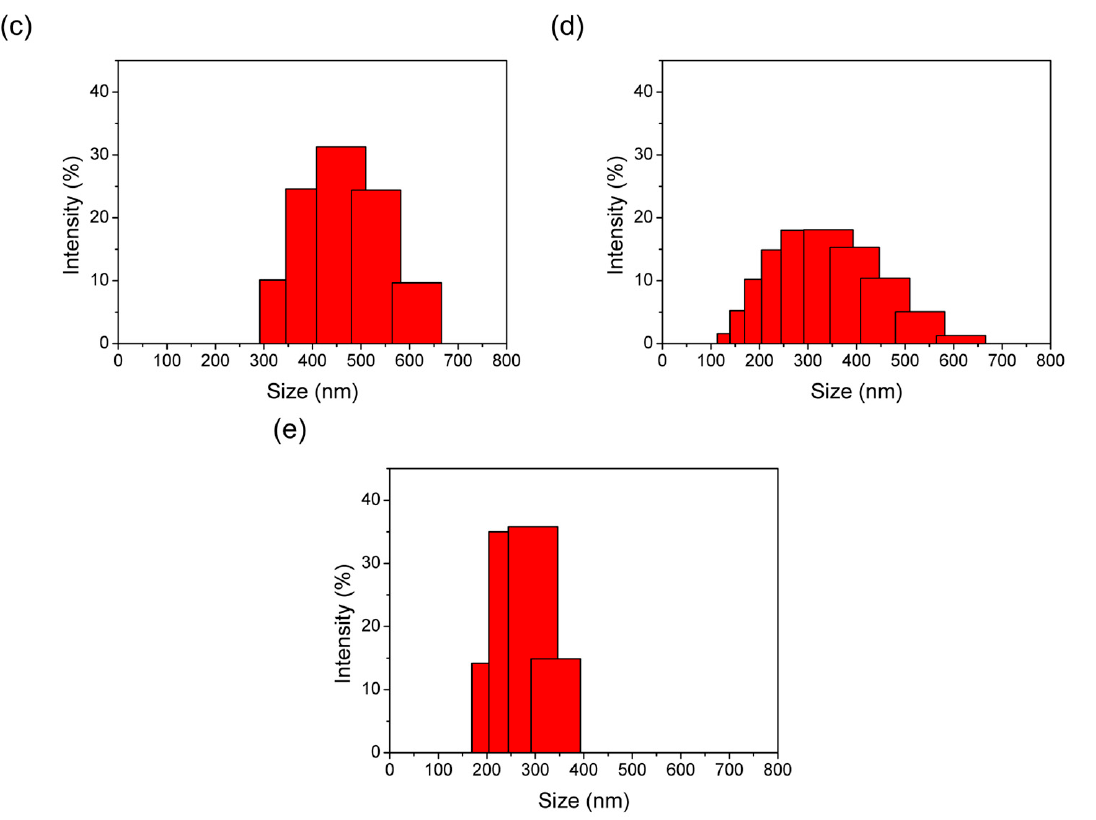
Figure 9. The DLS analysis of ZIF-8 samples with de novo- synthesis and impregnation methods using Ag 2 CO 3 as the precursor. ( a ) 01AgCO@ZIF (de novo), ( b ) 09AgCO@ZIF (de novo), ( c ) 25AgCO@ZIF (de novo), ( d ) 10AgCO/ZIF (impregnation), ( e ) 50AgCO/ZIF (impregnation).